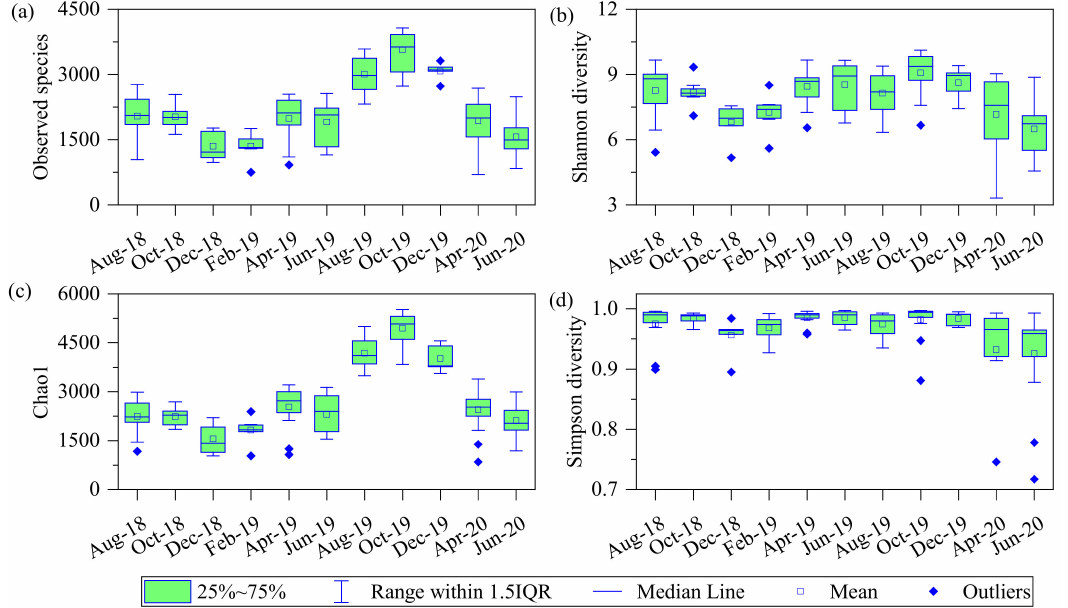
Figure 3. Average values of microbial community ( a ) observed species, ( b ) Shannon–Wiener diversity indices, ( c ) Chao1 diversity indices, and ( d ) Simpson diversity indices in different months.